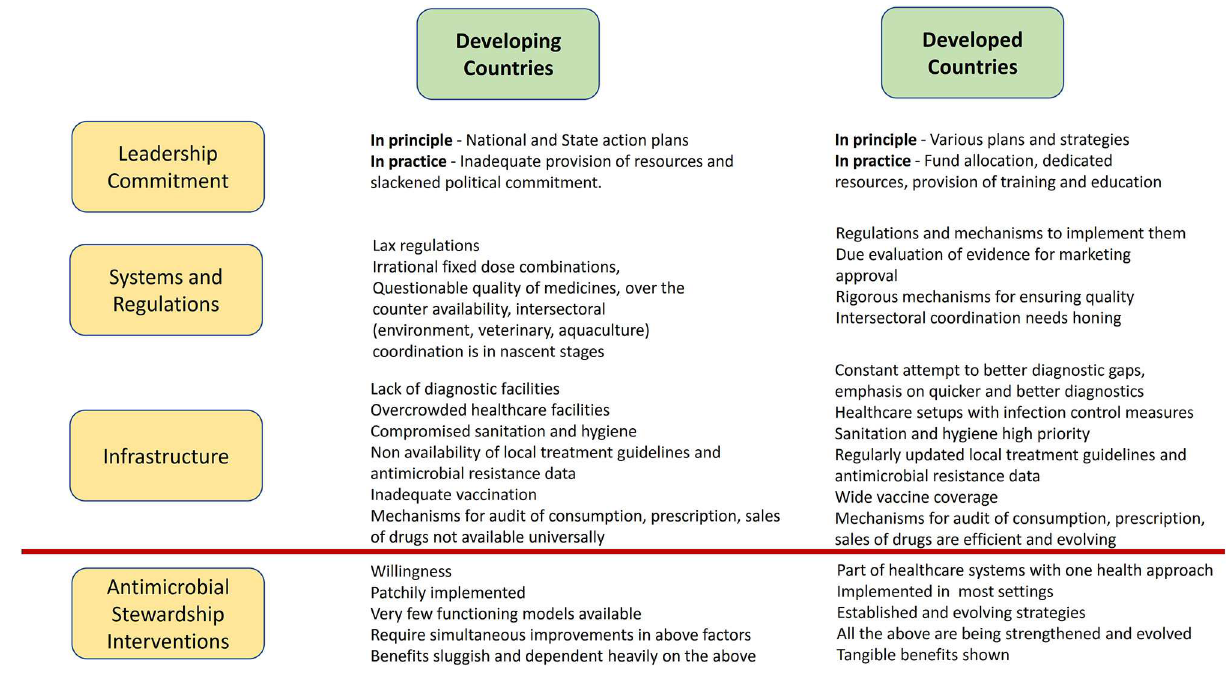
FIGURE 1 | Key differences between developing and developed countries that can affect implementation of AMS programs in